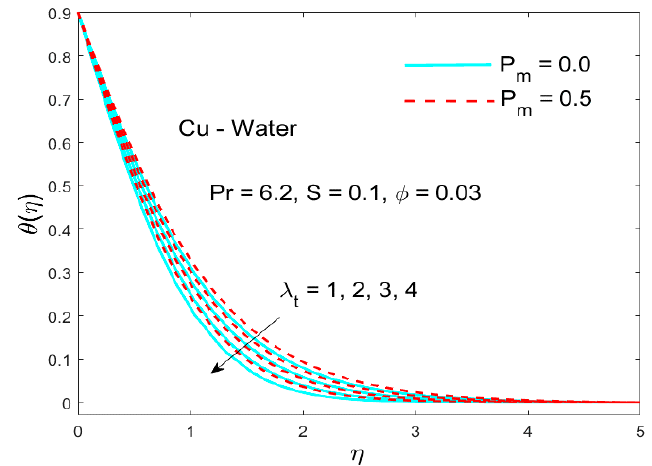
Figure 7. E ff ect of λ t on temperature field.